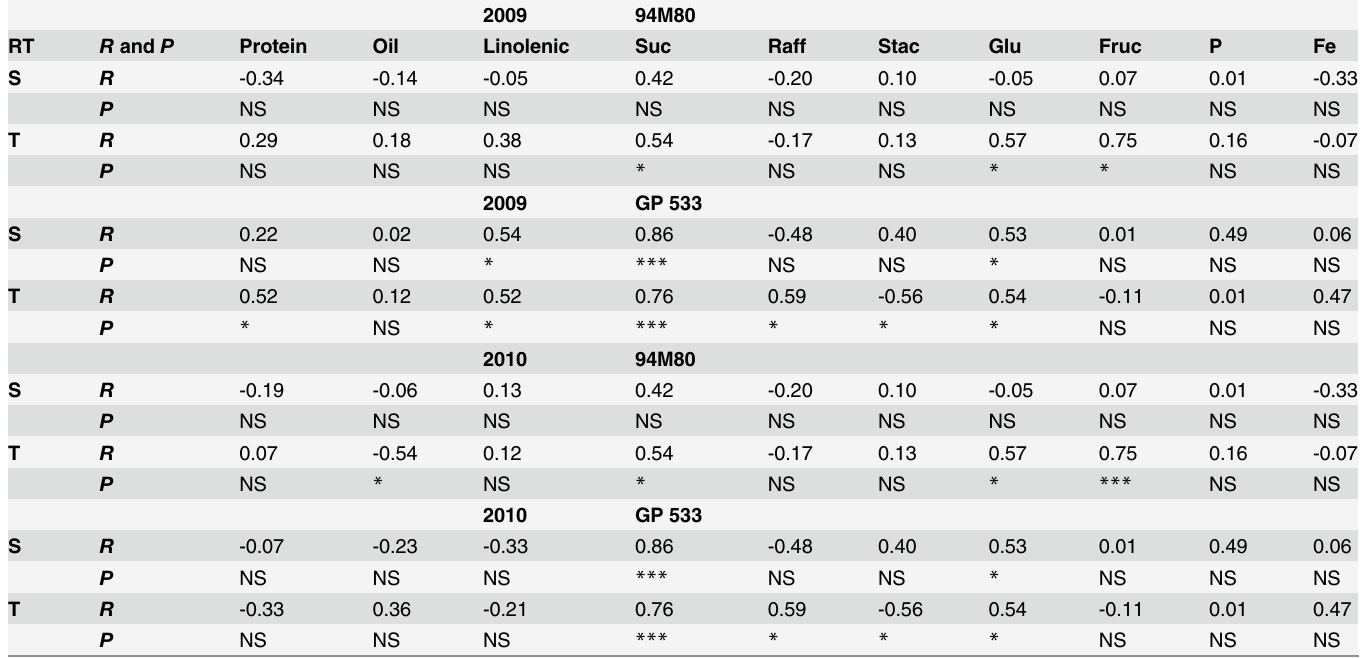
Table 7. Correlations ( R -values and P -values) between seeding rate (SR) and seed composition constituents (protein, oil, fatty acids, and sugars) and minerals (phosphorus, P, and boron, B) in soybean cultivars grown on single- (S) and twin- (T) rows in Sharkey clay soil 2009 and 2010 at Stoneville, MS, USA.